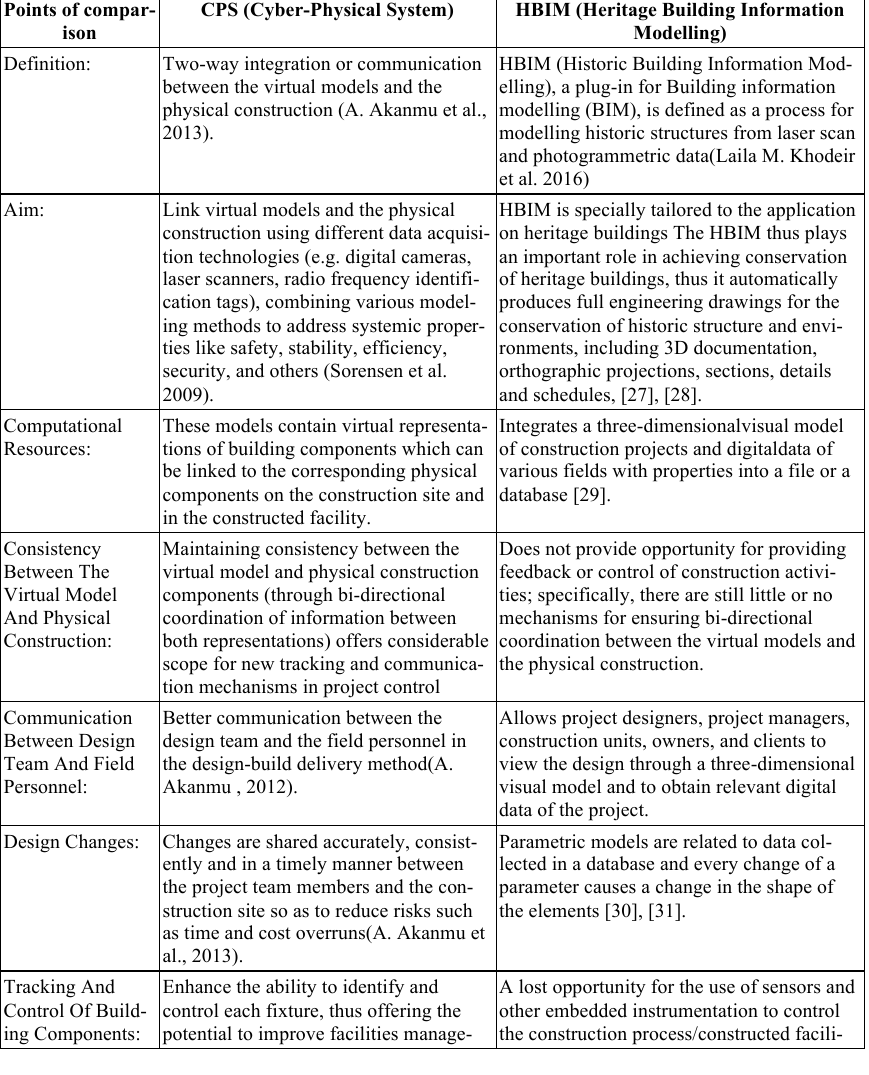
Table 2. Comparison between Cyber-Physical Systems and HBIM Points of compar-